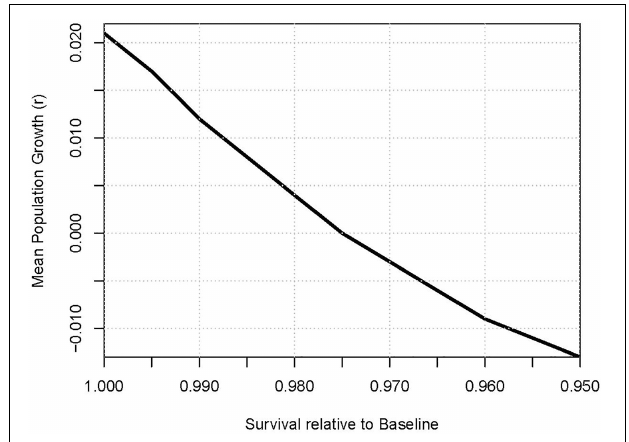
to r = 0.023 ( SD = 0.029), compared to r = 0.021 ( SD = 0.031) for the Baseline scenario ( Table 5 ). When the mortality rates for those 2 years were duplicated, calf mortality increased to 25.1%, juvenile mortality increased to 8.7%, and the growth rate was slightly lower than Baseline , with r = 0.019 ( SD =